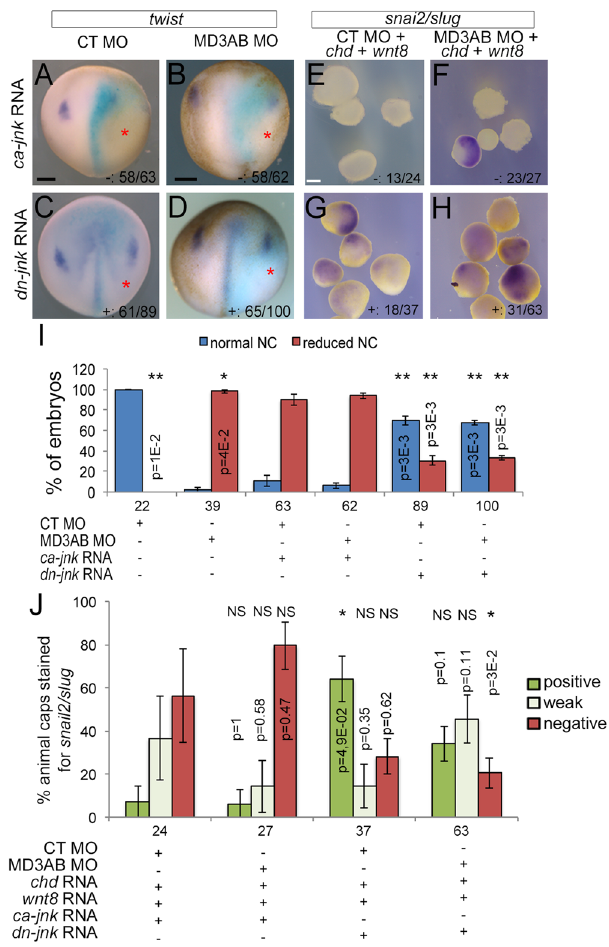
Figure 10. JNK pathway inhibition is required for neural crest formation in MarvelD3 knockdown embryos. Neural crest induction (stage 15) was analysed and quantified by WISH against twist in control and MD3AB morpholino embryos co-injected with constitutively active-jnk ( ca-jnk ) or dominant negative-jnk mRNA ( dn- jnk ) ( A – D and I ) and against snai2/slug in animal caps co-injected with chd mRNA + wnt8 mRNA + control morpholino or chd mRNA + wnt8 mRNA + MD3AB morpholinos and with constitutively active-jnk or dominant negative-jnk mRNA ( E – H and J ). Mann-Whitney test p values and the number of embryos or animal caps analysed are indicated; red asterisk, injected side of the embryo with light blue β -galactosidase staining. ( I ) blue bar, normal neural crest; red bar, reduced neural crest; ( J ) dark green bar, positive; light green bar, weak; red bar, negative snai2/slug staining. + , embryos or animal caps positive or weak for twist or snai2/slug expression; − , embryos or animal caps negative for twist or snai2/slug expression. Scale bars, 500 μ